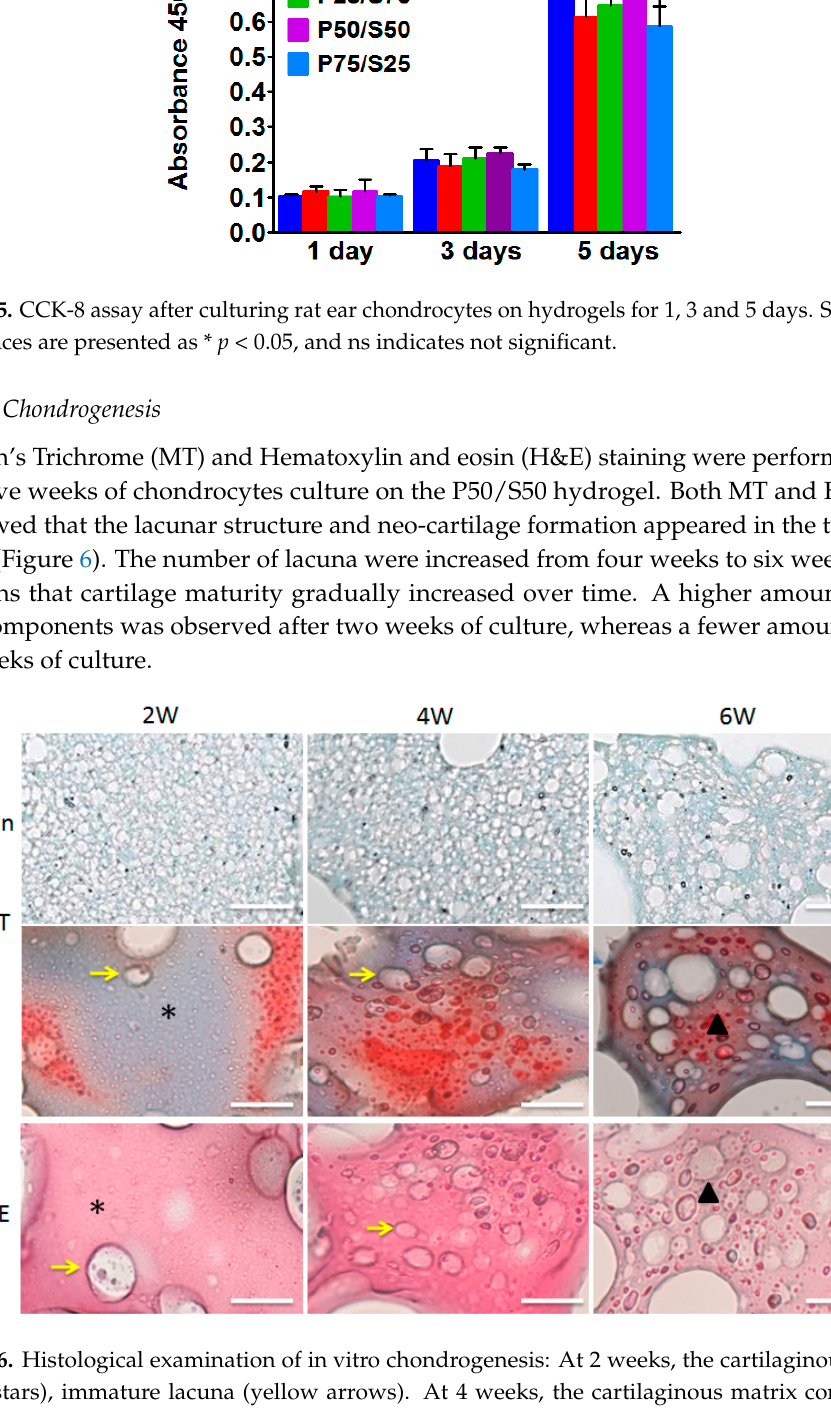
Figure 5. CCK-8 assay after culturing rat ear chondrocytes on hydrogels for 1, 3 and 5 days. Significant differences are presented as * p < 0.05, and ns indicates not significant.